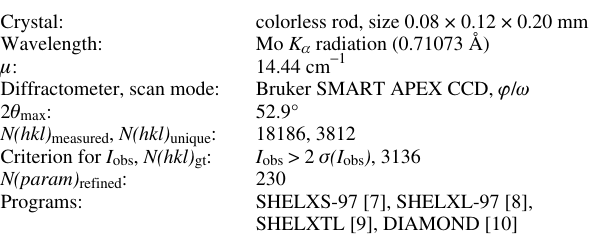
Table 1. Data collection and handling.